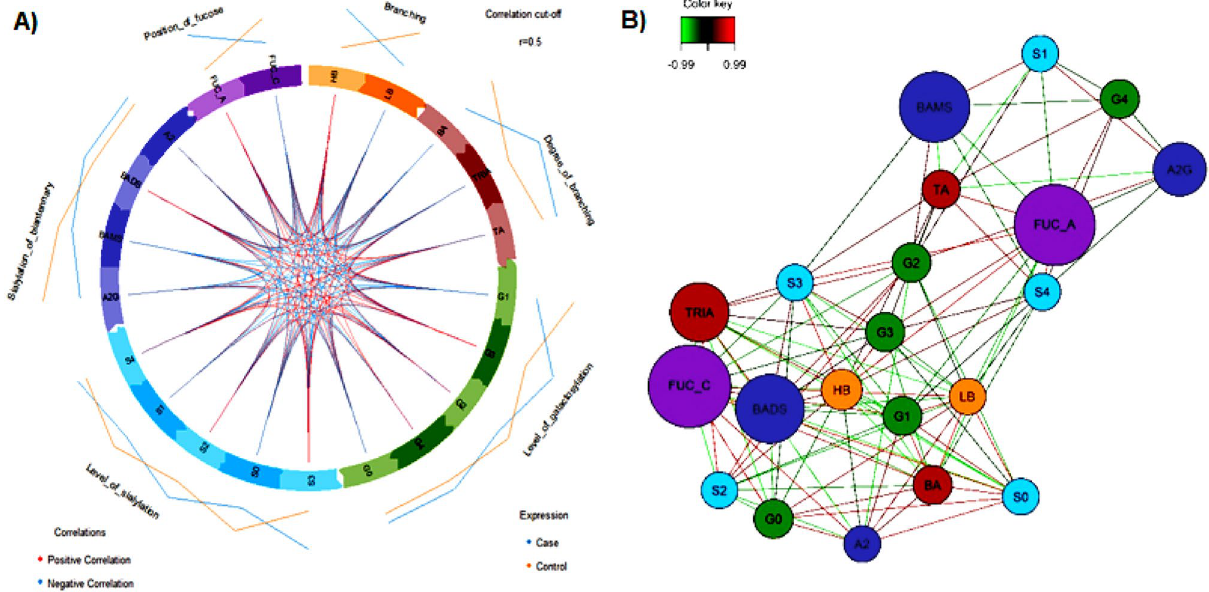
Figure 6. Correlation and relevance N-integrative supervised analysis with DIABLO. ( A ) Circos plots showing inter-block correlations. Spearman rank correlations were calculated for each pairwise comparison of variables. Variables with r = 0.5 between-block correlation were presented, ( B ) relevance network visualisation of the selected